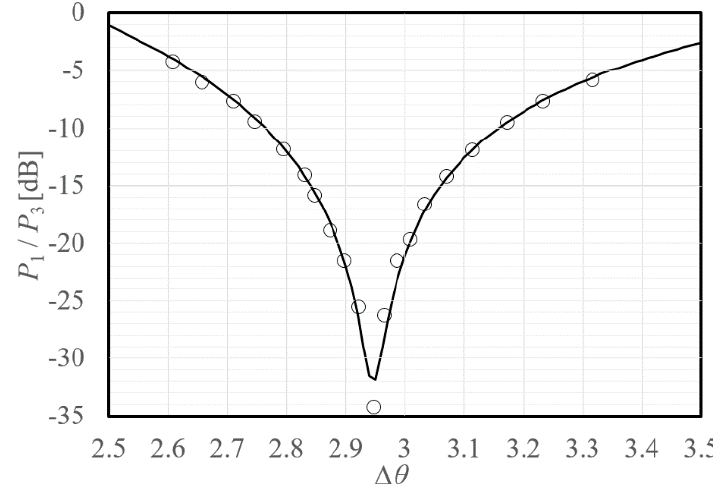
Figure 7. Intensity of ± 1st-order optical sidebands obtained from the experiment (open circles) and analytical model when RF attenuation 1/| η | =11.5 dB (solid line), normalized by ±3rd-order optical sideband intensity.